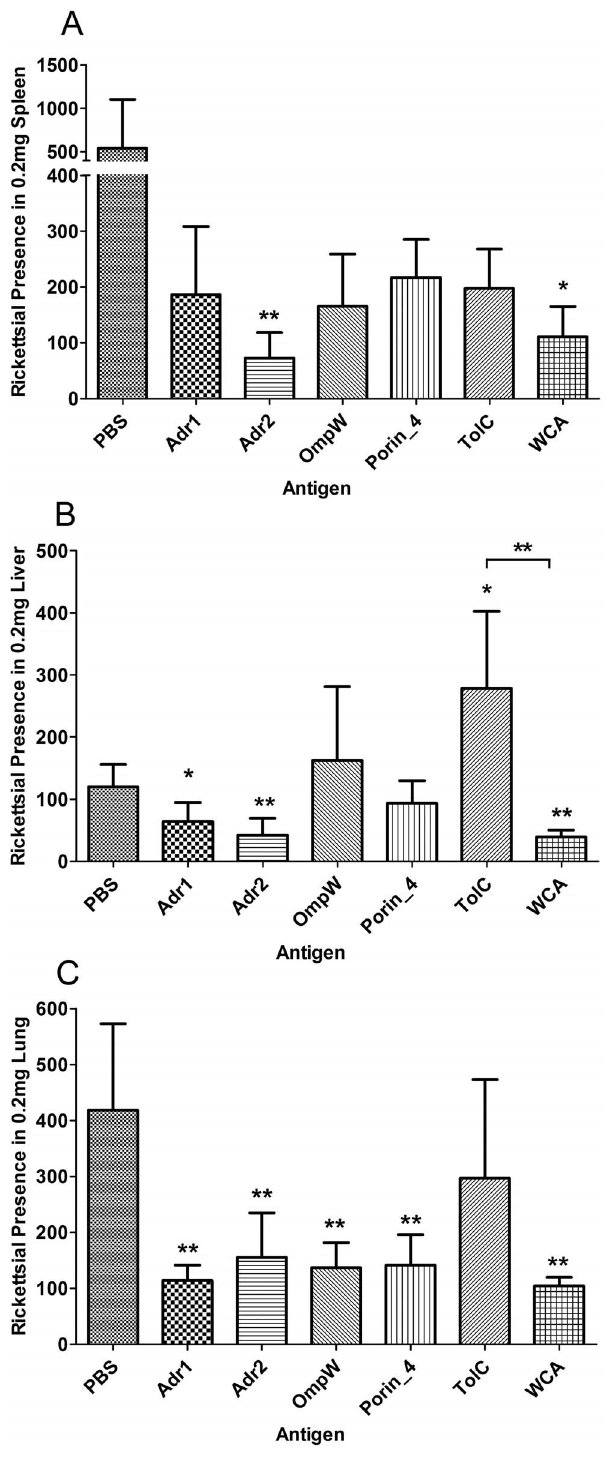
Figure 4. Protection against R.rickettsii infection induced by surface-exposed proteins. C3H/HeN mice ( n =5) were immunized three times with each rSEPs, WCA, or PBS, followed by a sublethal challenge with R. rickettsii . Five days after challenge, the mice were sacrificed and the rickettsial load in their spleens (A), livers (B), or lungs (C) was determined using R. rickettsii -specific qPCR. The rickettsial load is expressed as mean copies 6 standard deviations, and the results were analyzed using T test or Wilcoxon two-sample test according to their normality and homogeneity of variance, * P , 0.05 and ** P , 0.01.